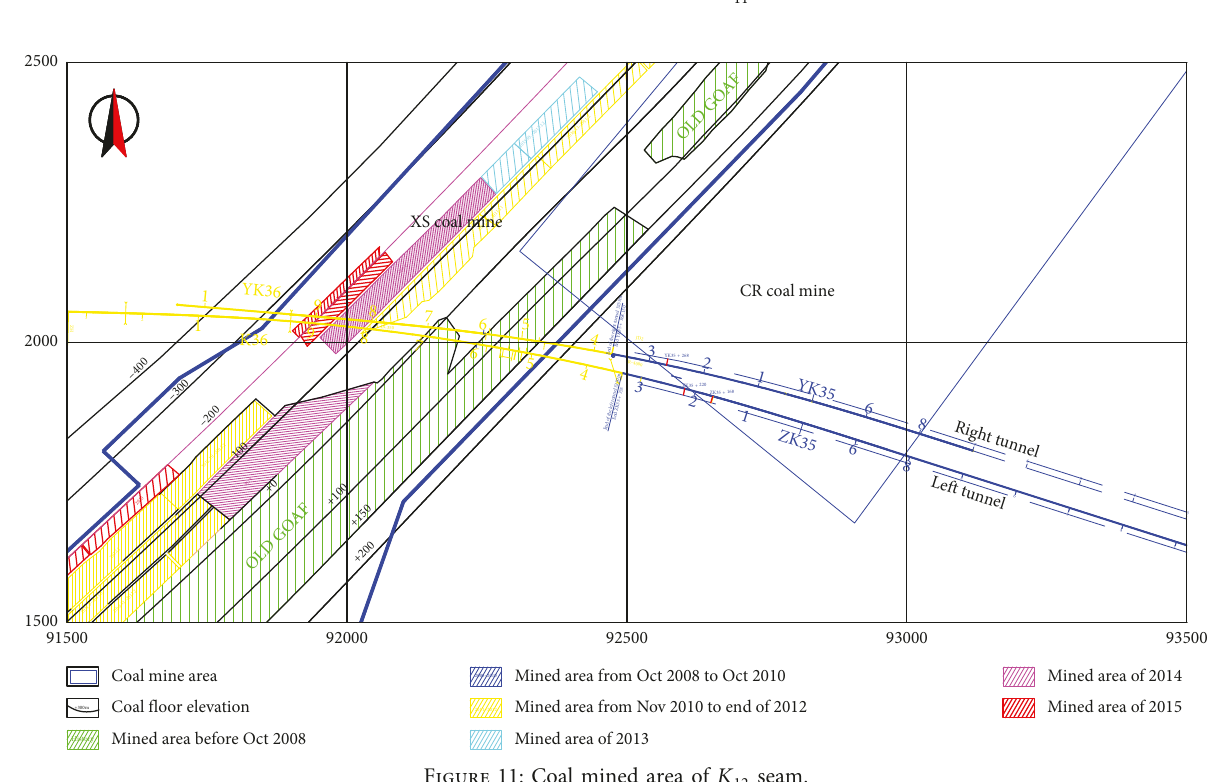
Figure 10: Coal mined area of K